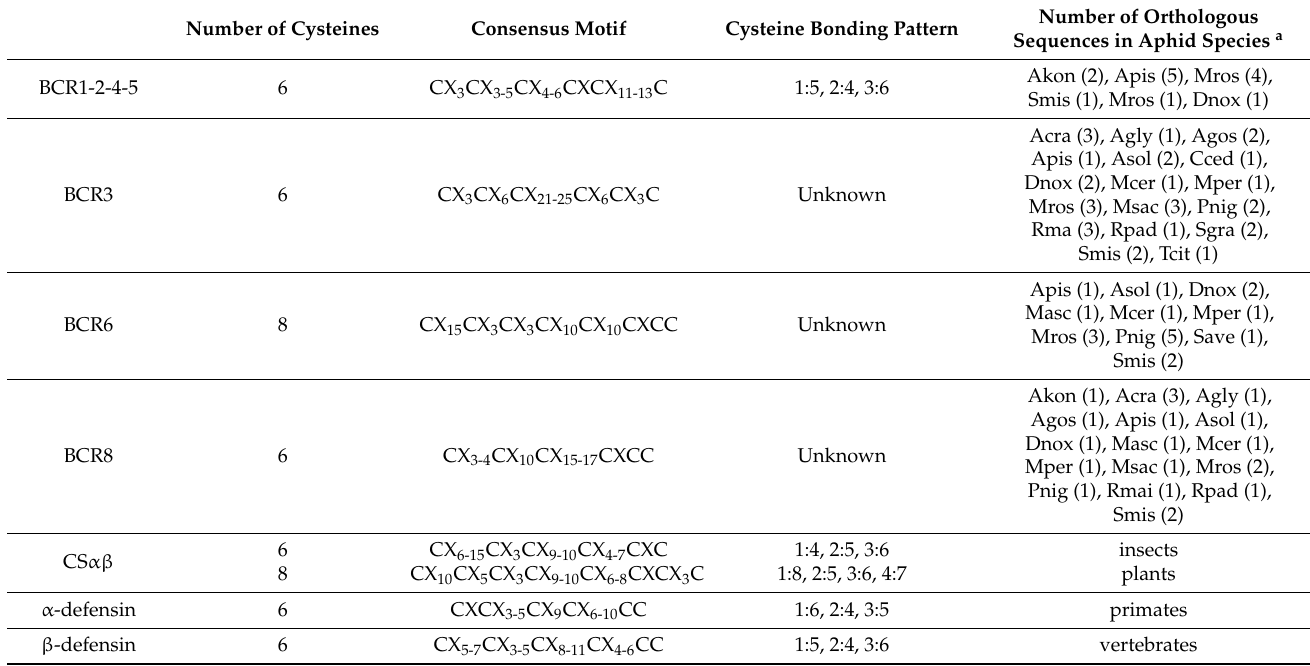
Table 3. Characteristics of the four BCR subfamilies and of the defensin